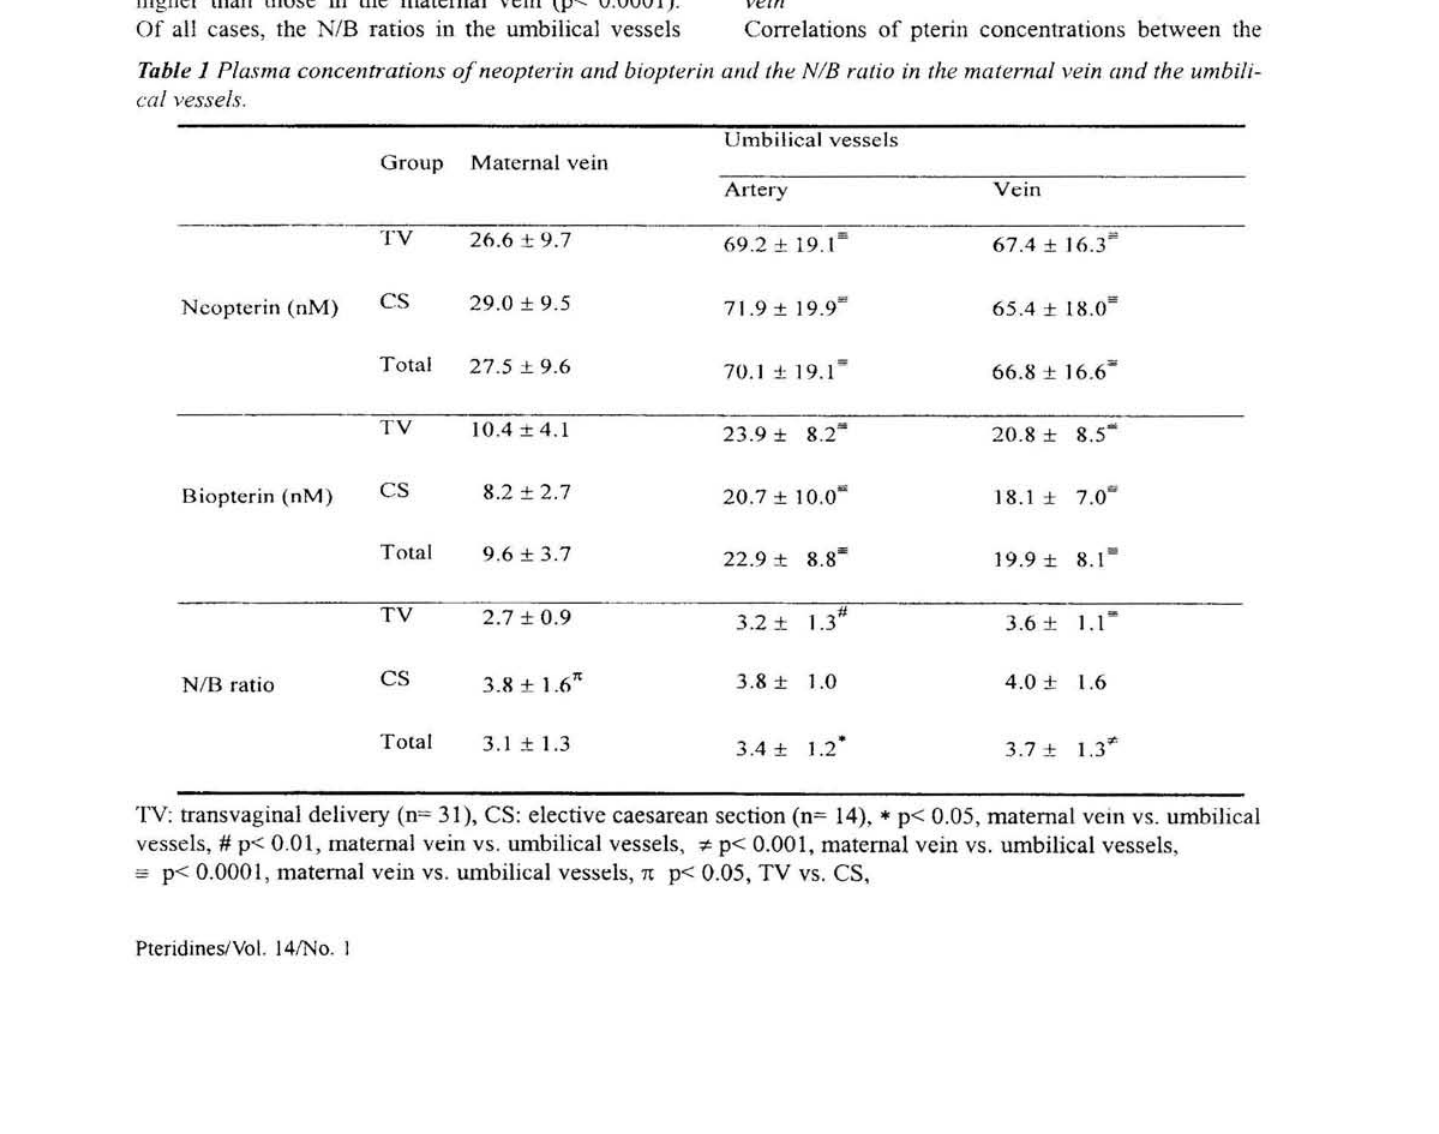
of neopterin and biopterin